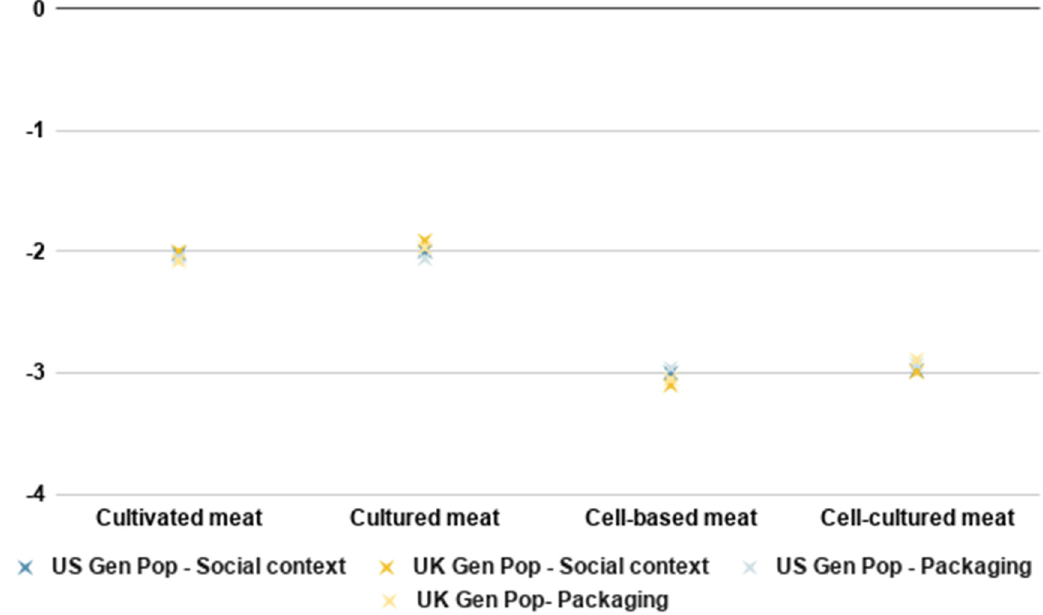
Figure 8. Ranking for different names in a social context and on packaging.